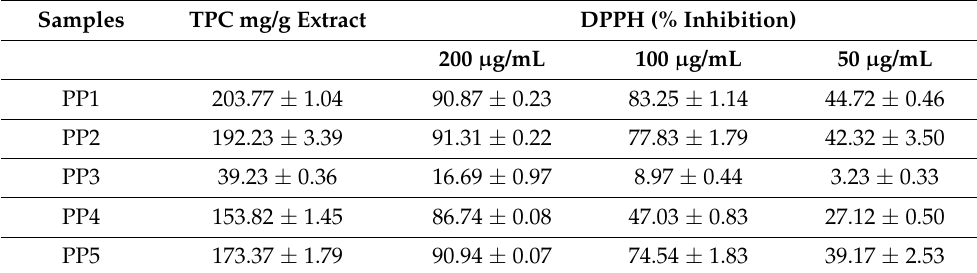
Table 5. TPC and antioxidant activity as DPPH % inhibition for propolis samples.